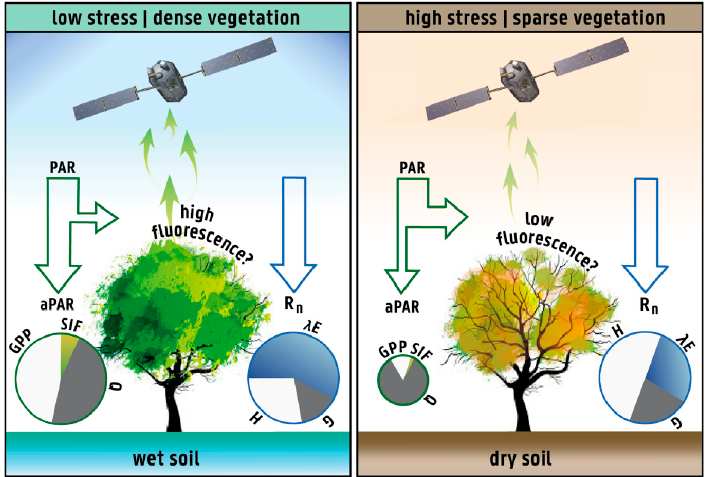
Figure 1. The hypothesis. Conceptual diagram of the expected surface energy balance and photosynthetically active radiation (PAR) partitioning in response to phenological and physiological constraints. Variables represent the absorbed PAR (i.e., aPAR), solar-induced fluorescence (SIF), non-radiative decay and non-photochemical quenching (Q), gross primary production (GPP), net radiation (R n ), latent heat ( λ E), sensible heat (H) and ground heat flux (G).